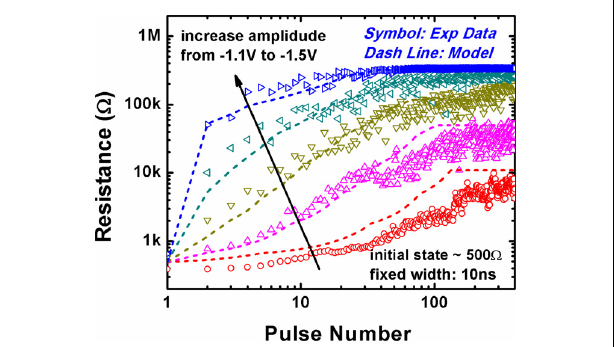
FIGURE A1 | Measured gradual RESET transition starting from ∼ 500 (cid:2) by hundreds of RESET pulses. The pulse amplitude was varied, and the parameters of the compact model were fitted.